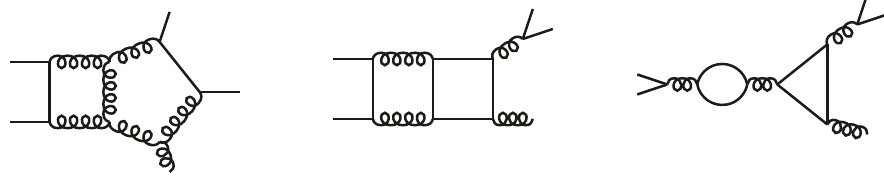
Figure 3 . Representative Feynman diagrams for leading-color A (2) ( q; (cid:22) q; Q; (cid:22) Q; g ) amplitudes, con- tributing at order N 0